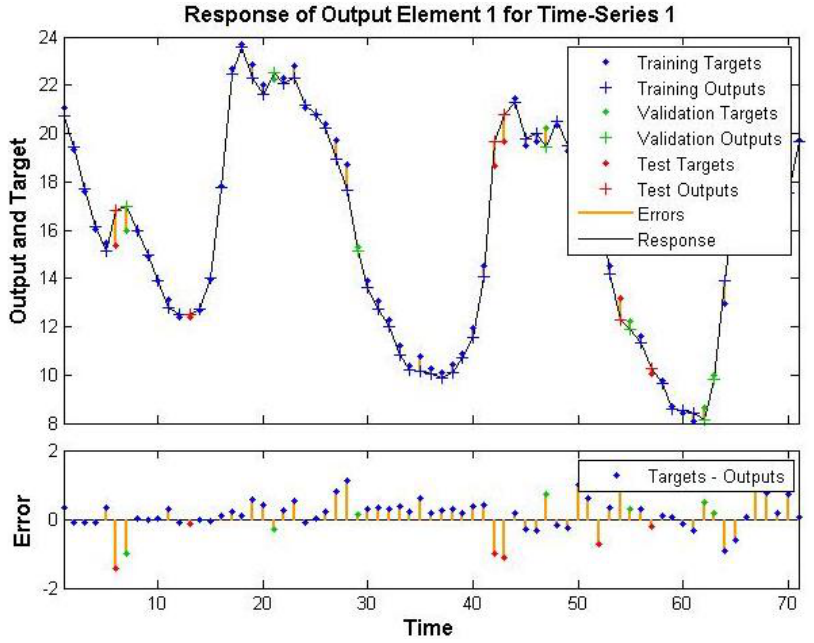
Figure 1. Time series of neural network training M c 3 run 1 NO 2 . Figure 2. M c 3 run 1 NO 2 regression of trained output data set. N t 2 (Naturally Ventilated Office) The difference between indoor and outdoor concentrations for N t 2 was significant during both monitoring runs. This was attributed to an unknown process (suspected to be heterogeneous reactions) significantly influencing the data set. In order to ensure this was not due to a once off event, data was